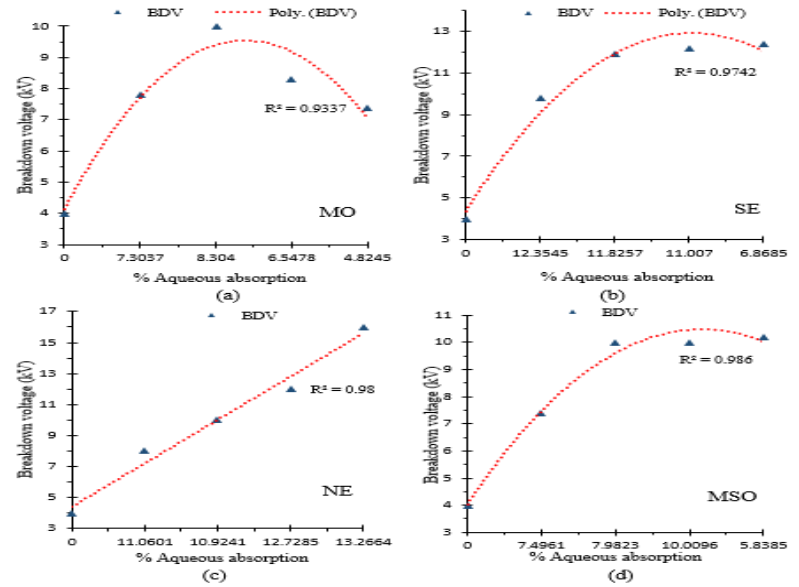
Figure 15. Regression plots for 0.5 mm thickness paper in various insulating oils. ( a ) Insulating liquid MO, ( b ) Insulating liquid SE, ( c ) Insulating liquid Ne, and ( d ) Insulating liquid